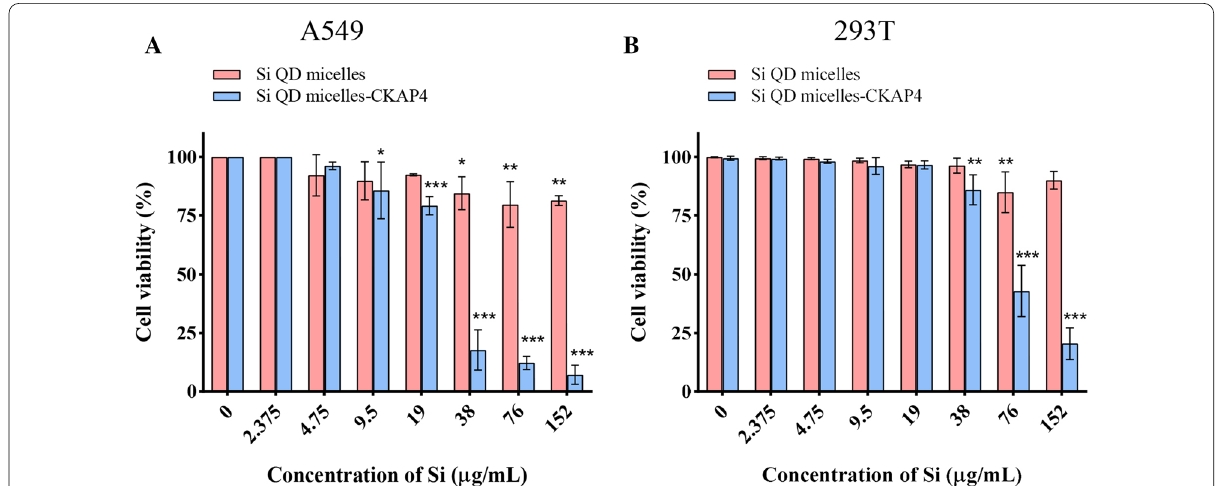
Fig. 3 Cell viability of A549 a and 293 T b incubated with different concentrations of Si QD micelles and Si QD micelles-CKAP4 (Si concentration: 0, 2.375, 4.75, 9.5, 19, 38, 76, and 152 µg/mL) for 2 h ( n